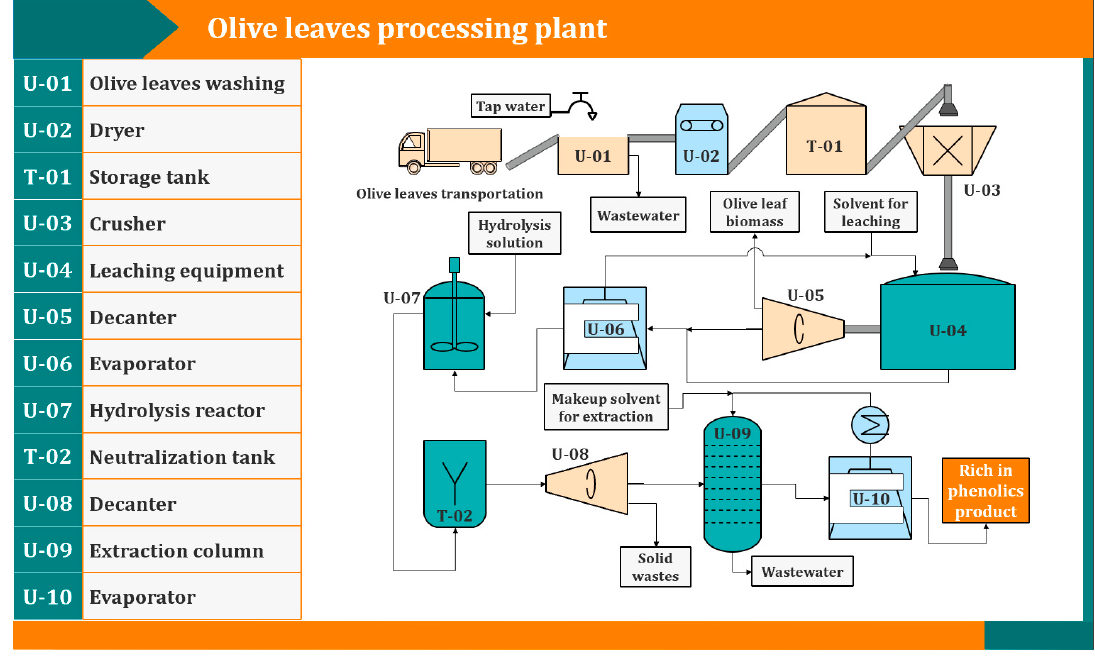
Figure 13. Proposed process scheme for the production of extracts rich in hydroxytyrosol.